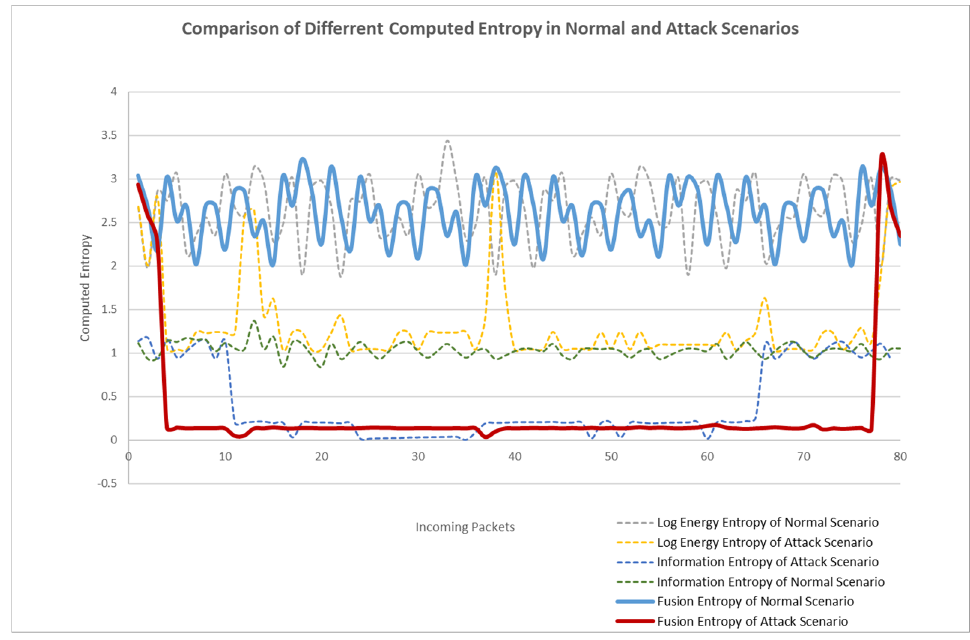
Figure 7. Comparison of different entropy variation.